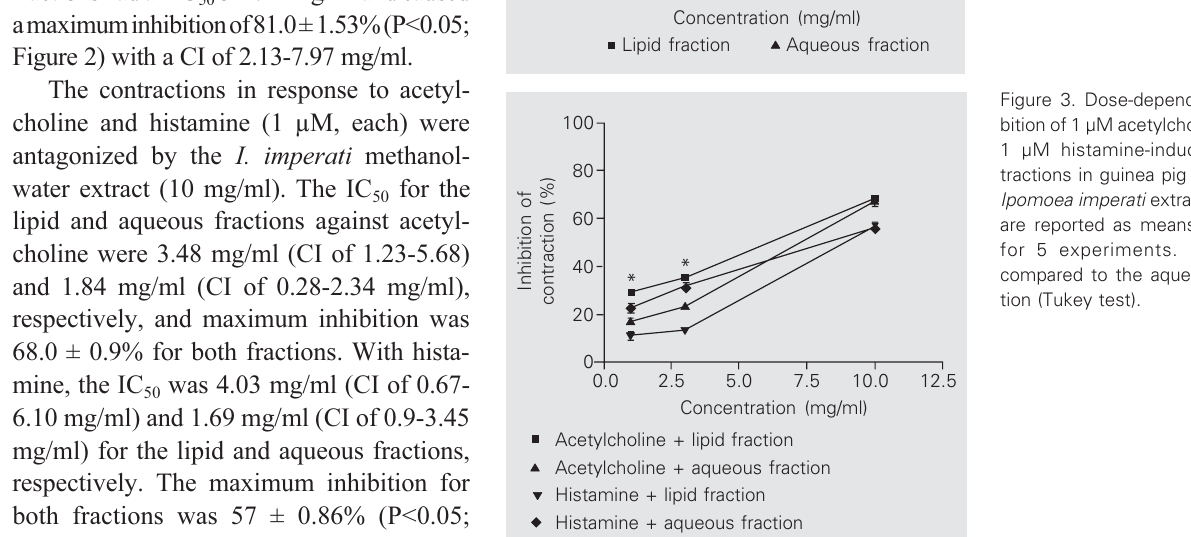
Figure 2. Dose-dependent inhi- bition of contractions by Ipo- moea imperati extracts in elec- trically stimulated isolated guin- ea pig ileum. Each point repre- sents the mean ± SEM of 5 experiments. Lipid fractions (1.0, 3.0 and 5.0 mg/ml) were significantly different from the aqueous fraction (*P<0.05, Tukey test).